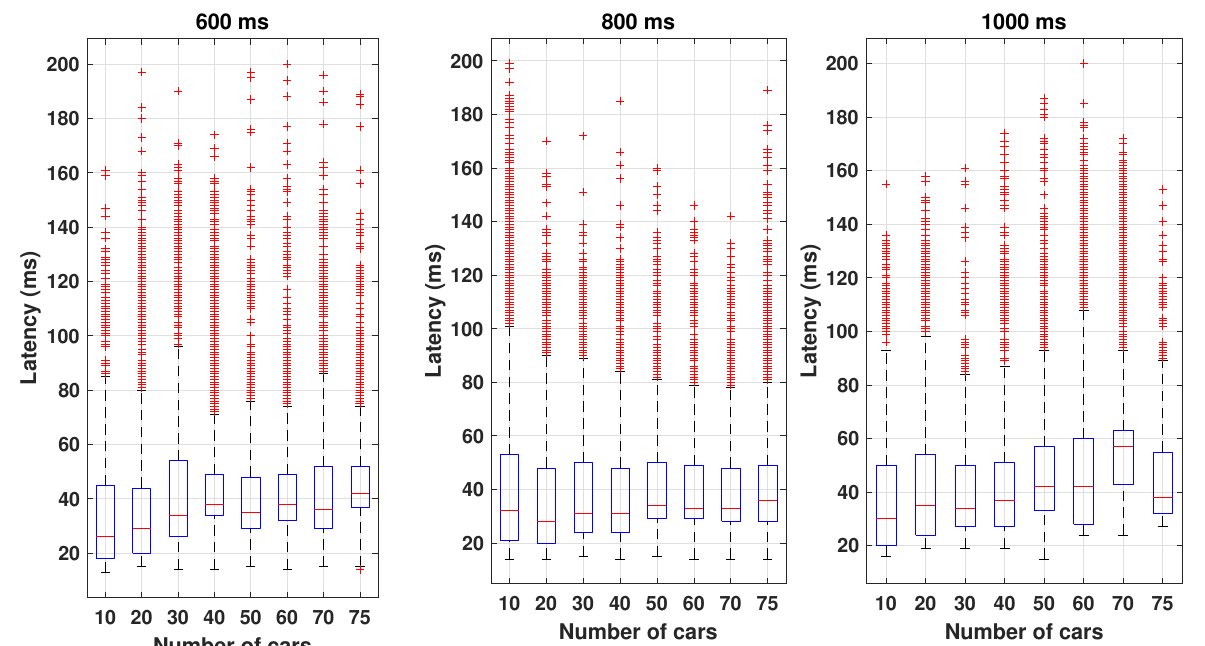
Figure 20. Latency values for 600 ms, 800 ms, and 1000 ms dissemination intervals using Ethernet + LTE